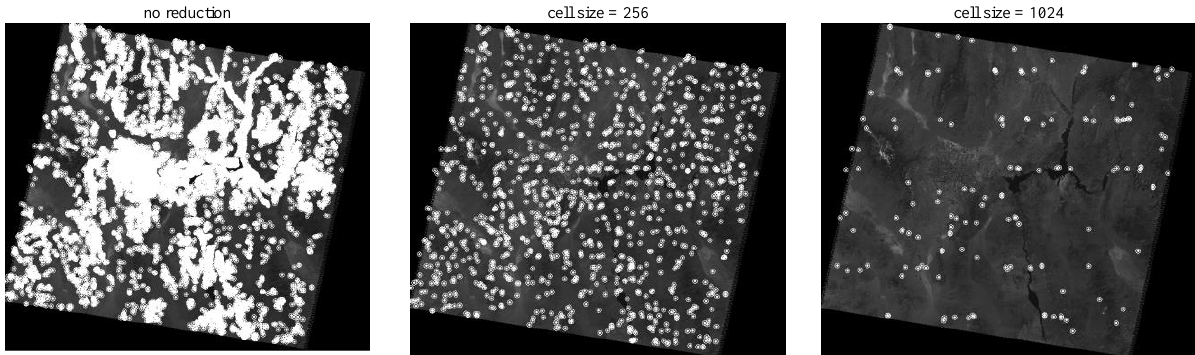
Figure 6. Features reprojected onto the master after Least Squares adjustment incorporating feature